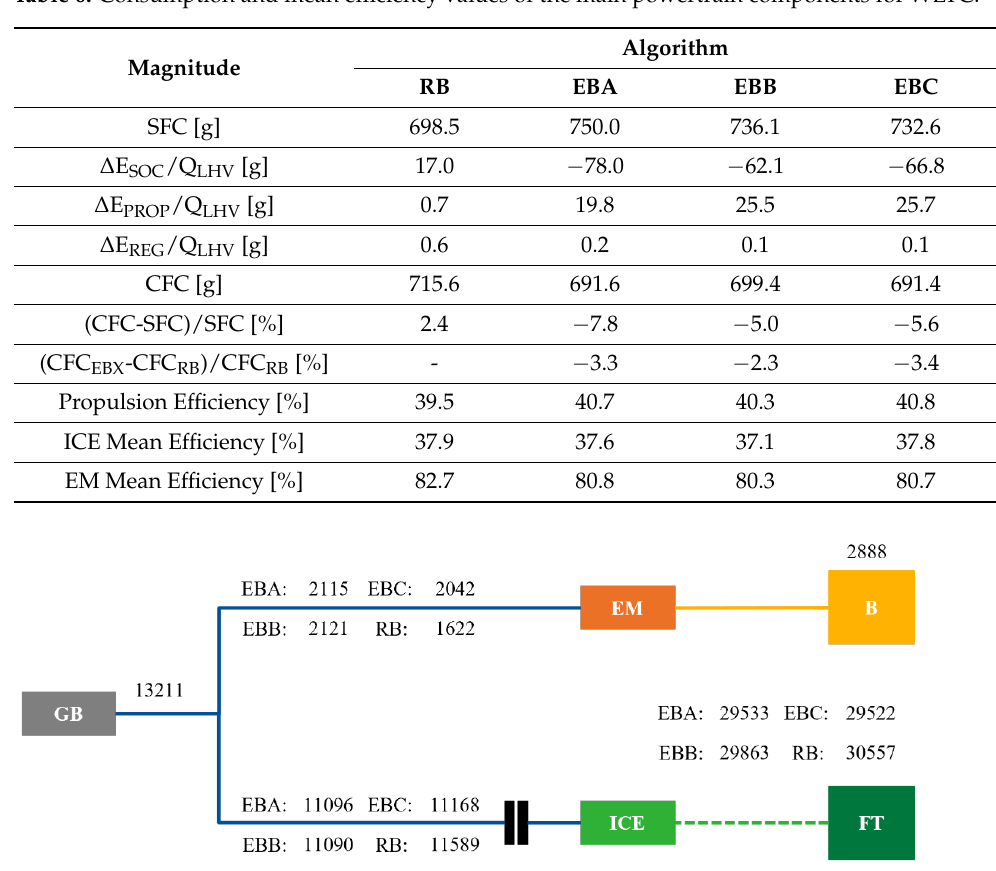
Table 6. Consumption and mean efficiency values of the main powertrain components for WLTC . Magnitude